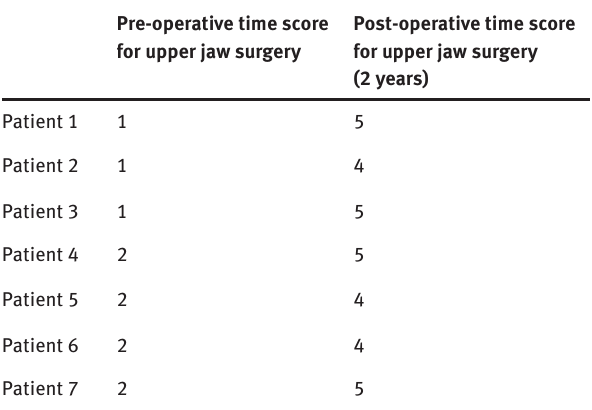
Table 2: Aesthetic evaluation at upper jaw of 7 patients selected at pre-operative and 2 years post-operative time following Likert scale.